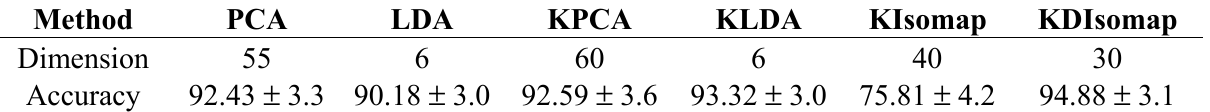
Table 3. The best accuracy (%) of different methods on the Cohn-Kanade